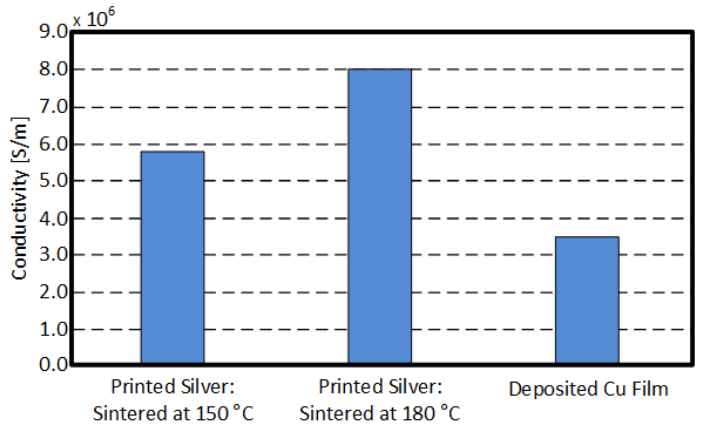
Figure 9. Surface SEM (Scanning Electron Microscope) images of ( a ) direct silver nano-particle printing method and ( b ) indirect thin copper film printing method.